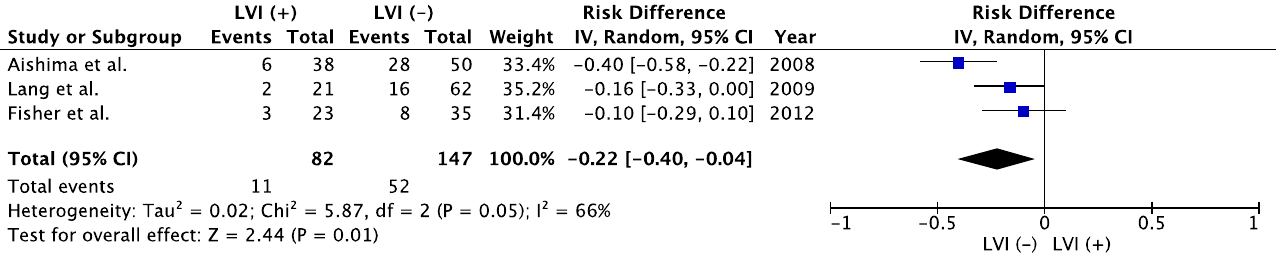
Figure 2. Meta-analysis of studies evaluating the impact of lymphatic vessel invasion on 5-year over- all survival for intrahepatic cholangiocarcinoma. CI, con fi dence interval; IV, inverse variance; LVI, lymph vessel invasion [38,61,74].